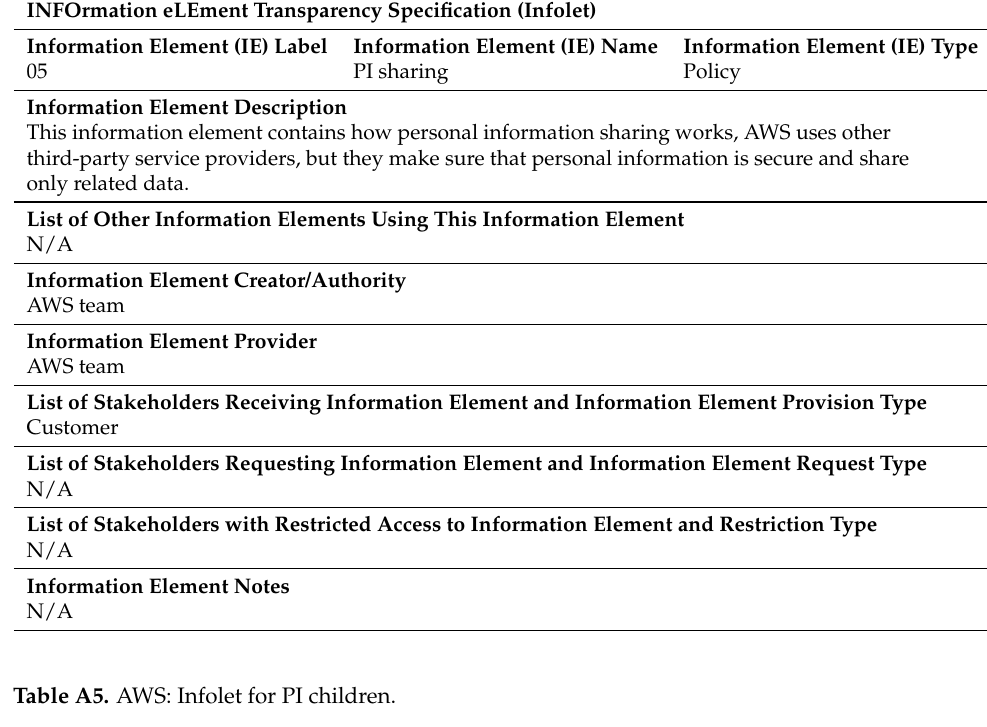
Table A4. AWS: Infolet for PI sharing.